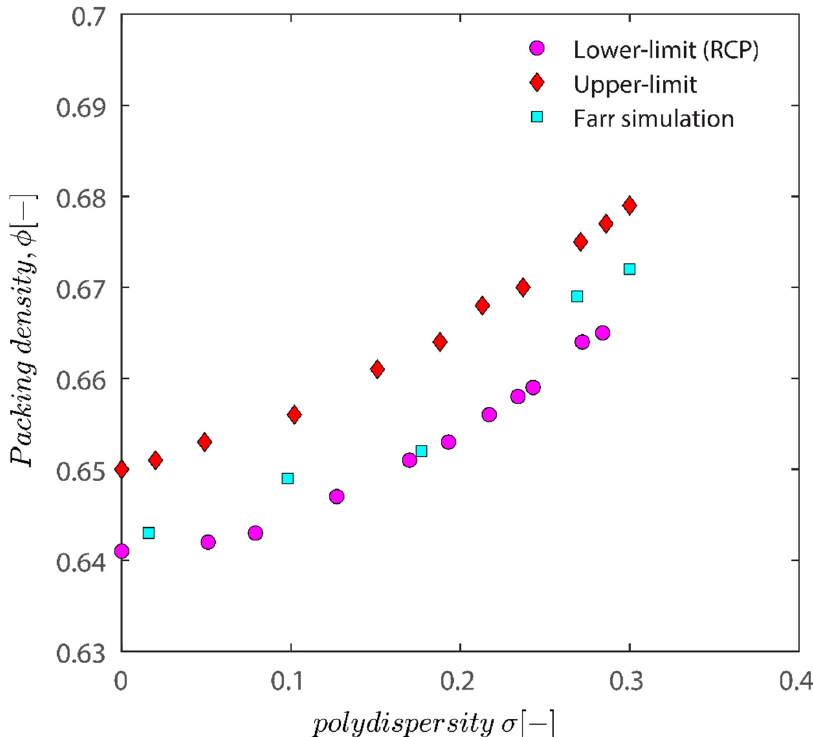
Figure 12. Assessment of the impact of polydispersity on packing density. Comparison between the result of simulation used in this manuscript and results of the semi-theoretical approach of Faar in ref. [79].